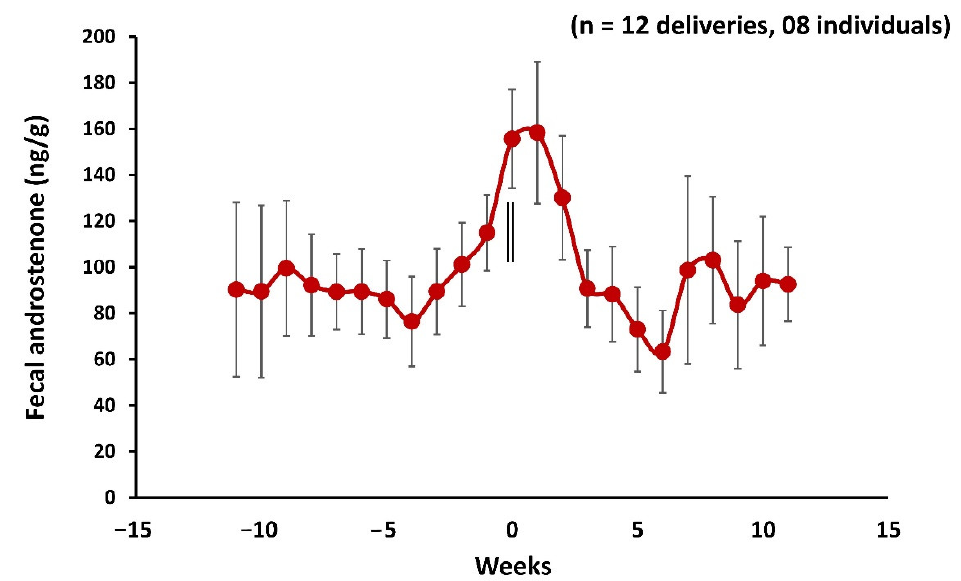
Figure 7. Profile of mean ± SEM weekly fecal androstenone in mouse deer during 11 weeks before and post parturition. The zero week and vertical bars indicate the parturition, mating, and postpartum estrus ( n = 12) were recorded in eight individuals.